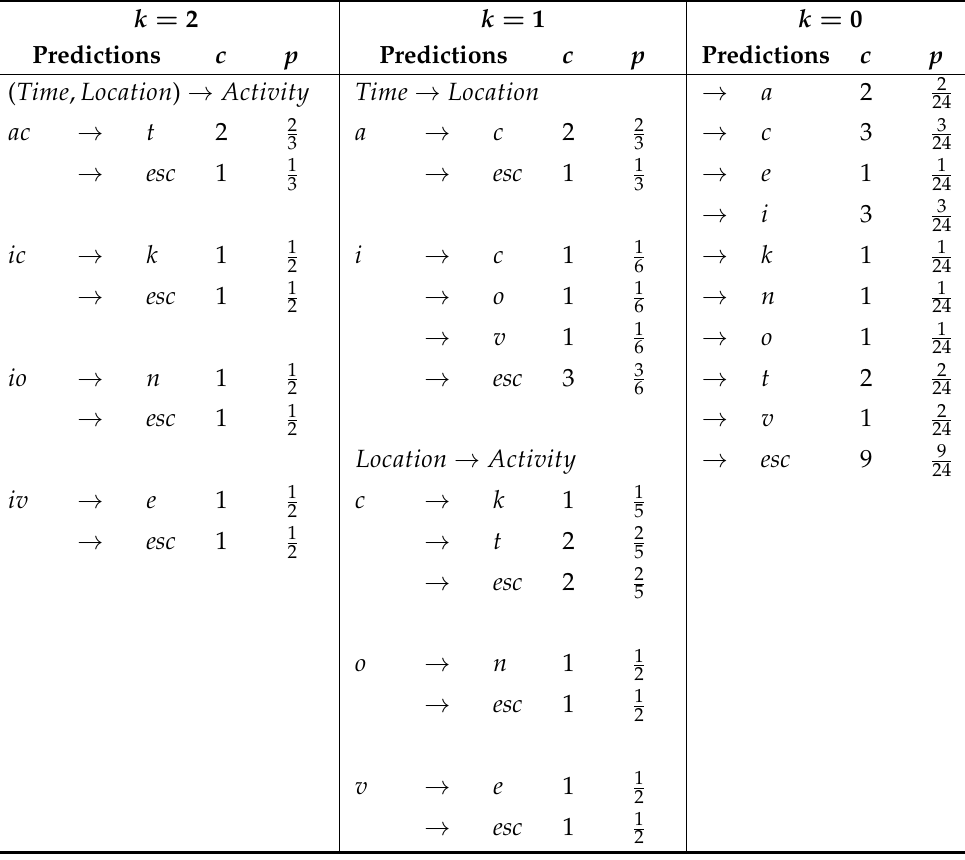
Table 1. PPM model showing the three context models with k = 2,1, and 0 after processing input string ‘ activeactionick ’. The frequency counts in the column labelled c and the probabilities p of each symbol are maintained by the